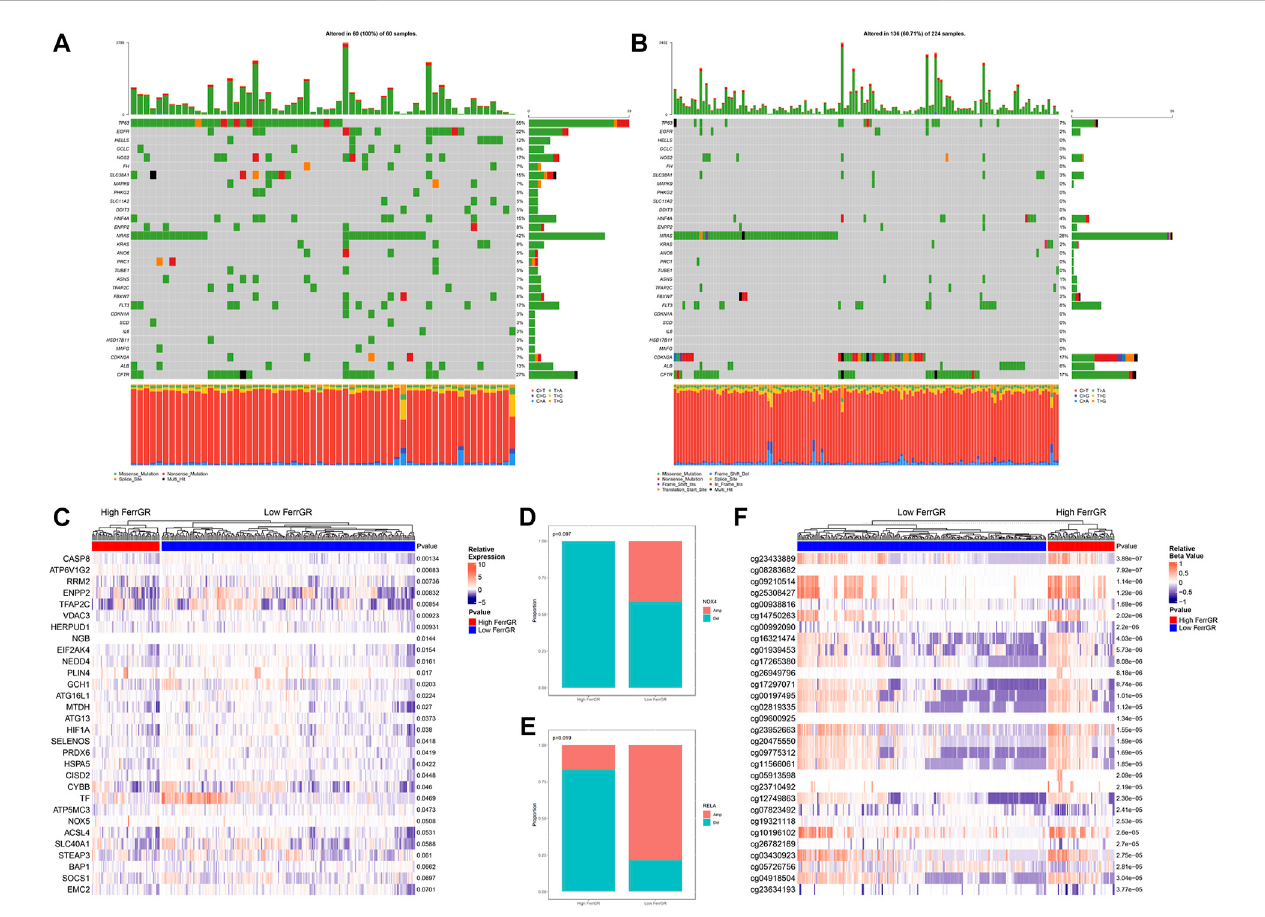
FIGURE 5 Analysis of ferroptosis-related genomic variation in the high FerrRG group and low FerrRG group (A,B) waterfall plots represent mutation information of FRGs in each sample of the high FerrGR group and low FerrGR group SKCM patients, (C) Heatmap of top 30 differentially expression FRGs between the high- and the low-FerrGR groups, (D,E) The CNV mutation proportion of (D) RELA, and (E) NOX4 between groups, Amp: Gene ampli fi cation, Del: gene deletion (F) Heatmap showed the methylation sites of FRGs with top 30 signi fi cantly different methylation levels between